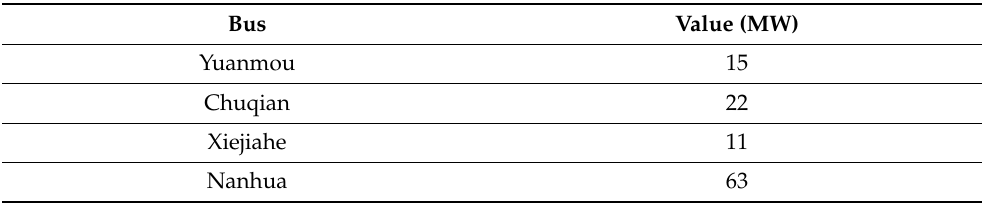
Table 2. Parameters of the loads.